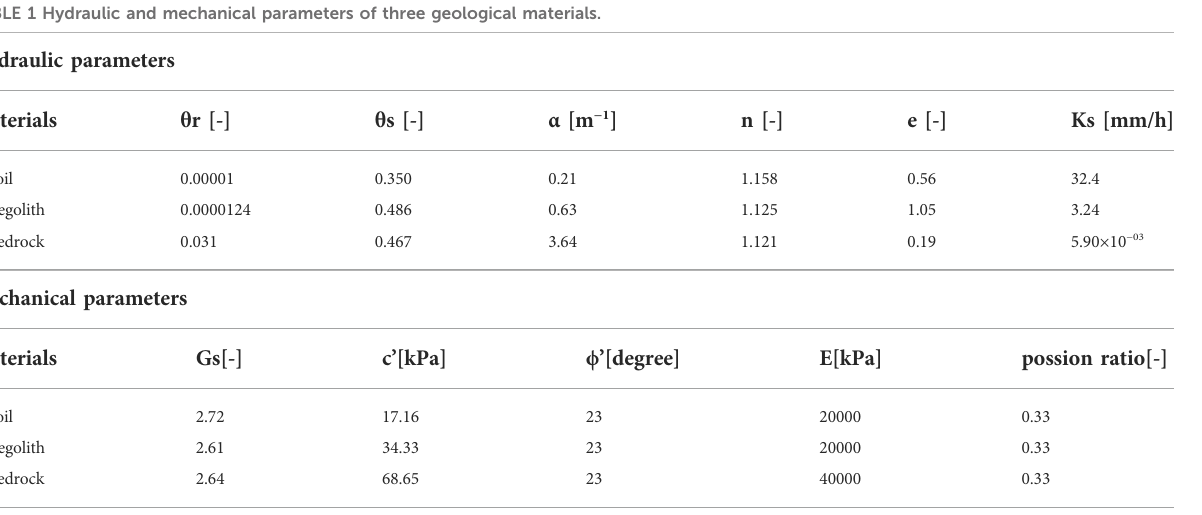
TABLE 1 Hydraulic and mechanical parameters of three geological materials.